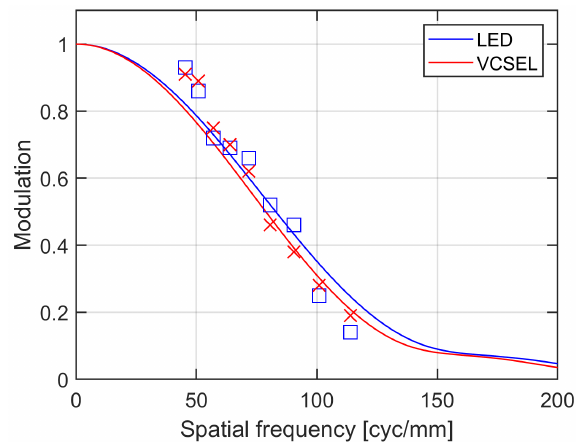
Figure 7. Modulation transfer function of the imaging system at the object plane with both the LED and VCSEL illumination systems. The results report the modulation transfer function (MTF) evaluated with both the knife-edge method and the USAF-1951 resolution